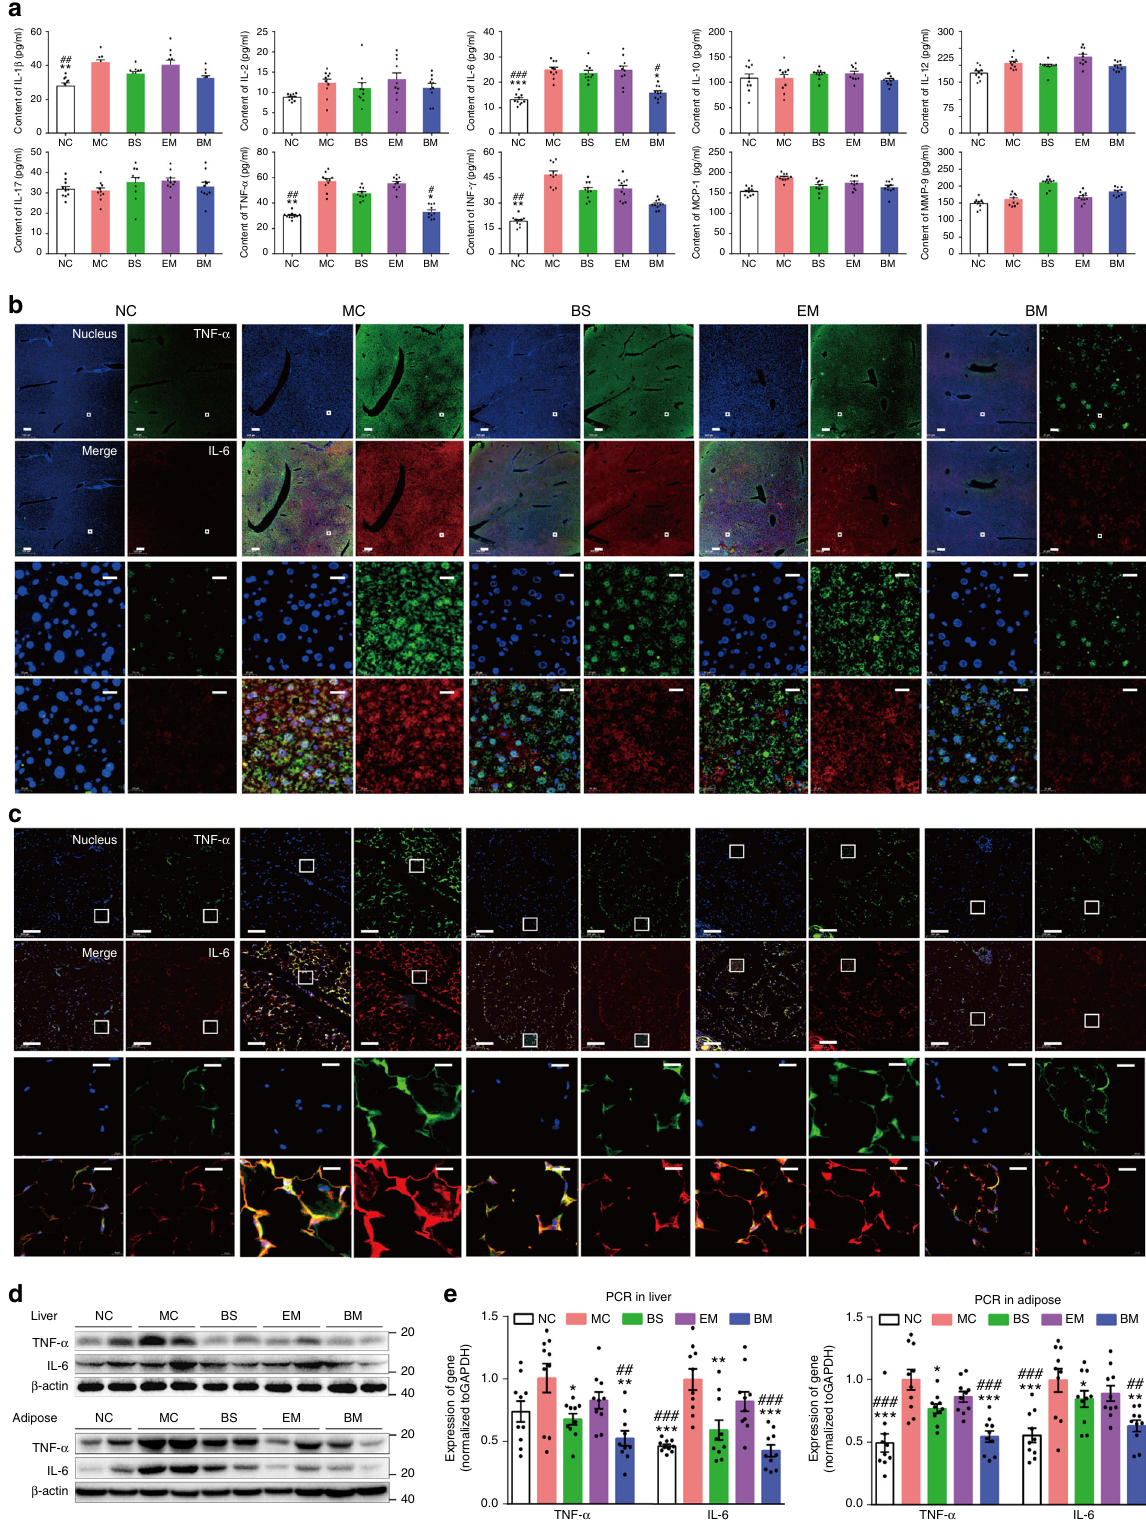
treated and untreated mice. No signi fi cant differences were detected between treatment group and the untreated control group in the plasma levels of ALT, AST, creatinine (CRE) and blood urea nitrogen (BUN), indicating a good tissue compatibility of the delivery system designed in this study.